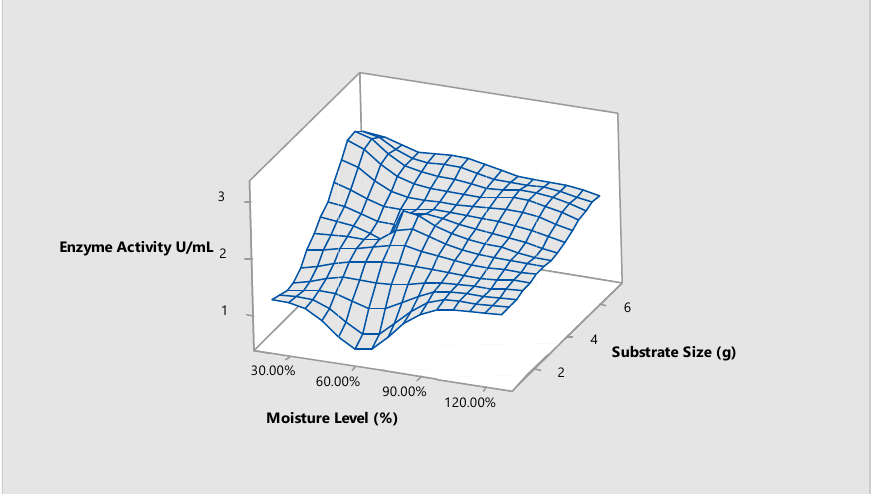
Figure 6. Surface plot of Enzyme Activity (U/mL) vs. Substrate Size and Moisture Level.